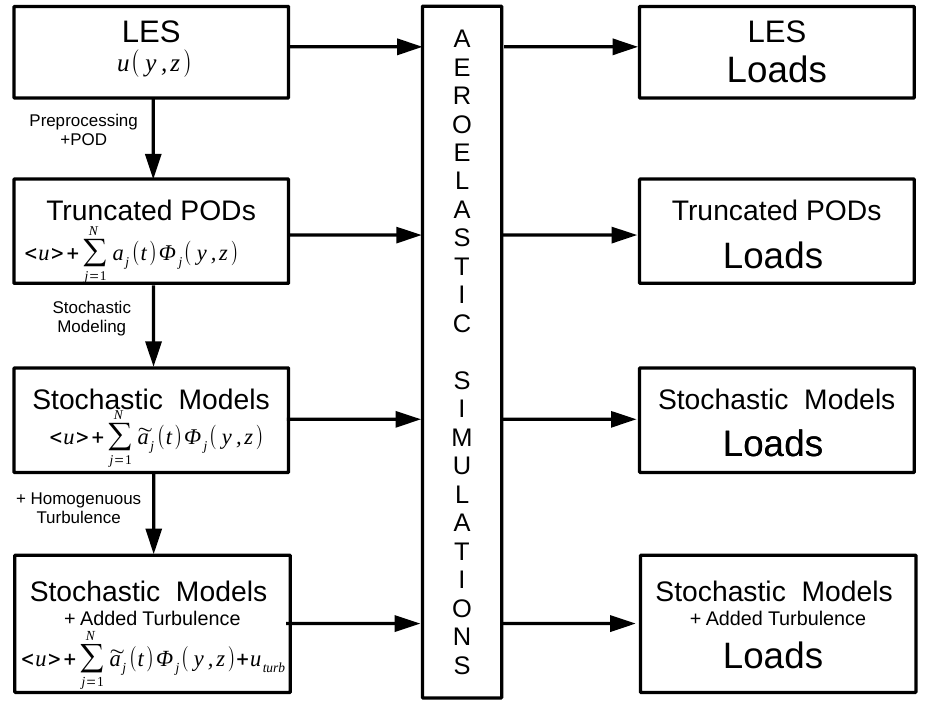
Figure 4. Illustration of our modeling approach and its verification: In the left part of the figure, the different steps leading to reduced wake descriptions are presented. These different descriptions are all used as inflows to aeroelastic simulations. All resulting loads are then compared in order to give insight into the strength and weaknesses of the simplified wake flows. The mathematical notation used in the figure will be explained in the rest of this